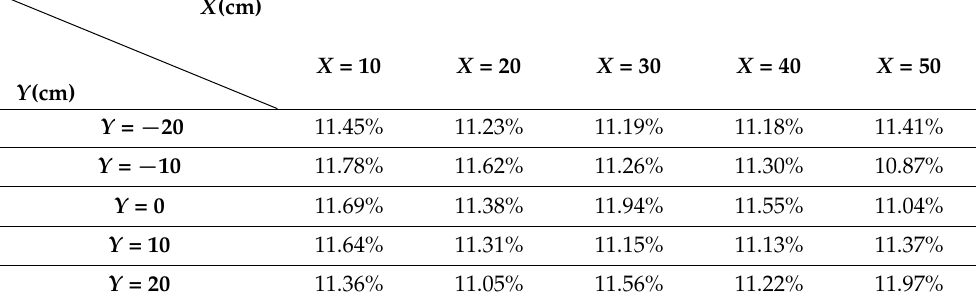
Figure 7. ( a ), ( b ) and ( c ) Simulated energy spectra at positions (10, 0), (30, 0) and (50, 0), respectively. Table 4. Energy resolutions at source positions ( X , Y ) obtained by simulations.